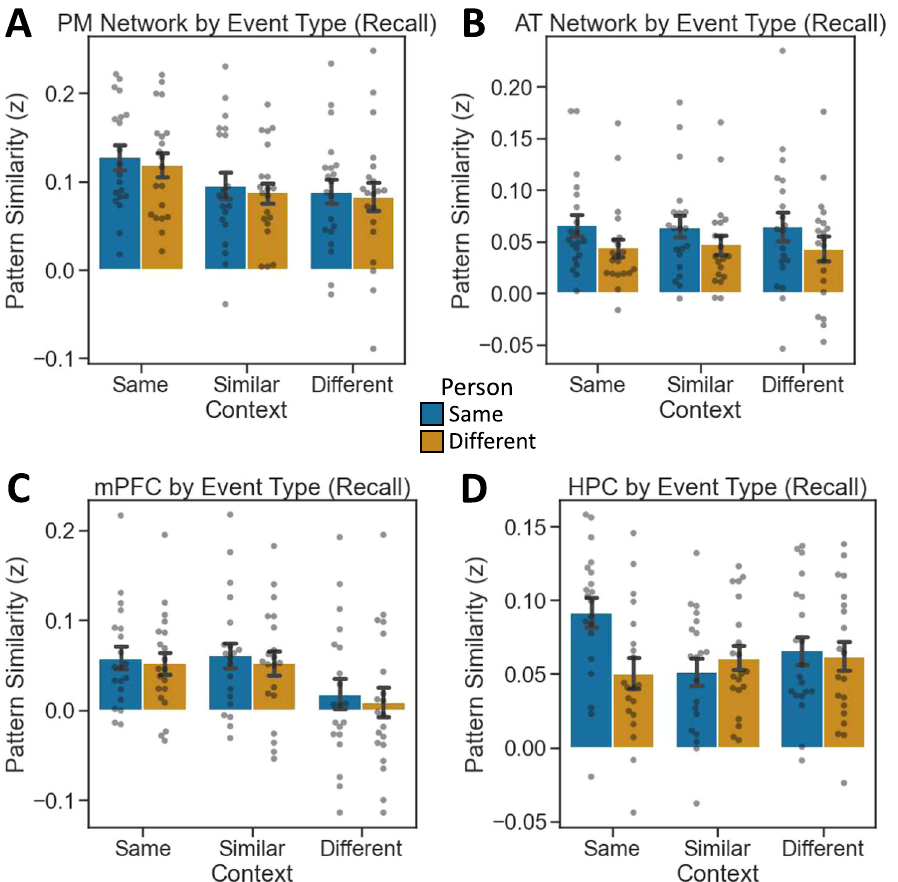
Fig. 6 | Recall pattern similarity by event type. A PM Network patterns show context-speci fi city. B AT Network patterns show person-speci fi city. C mPFC